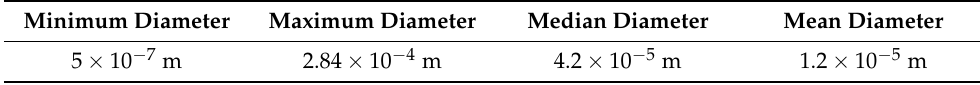
Table 3. Particle size distribution detail in Zhoushan.